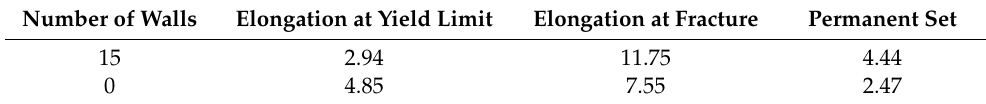
Table 5. Elongation values for selected numbers of walls Table 5 . Elongation values for selected numbers of walls (mm).